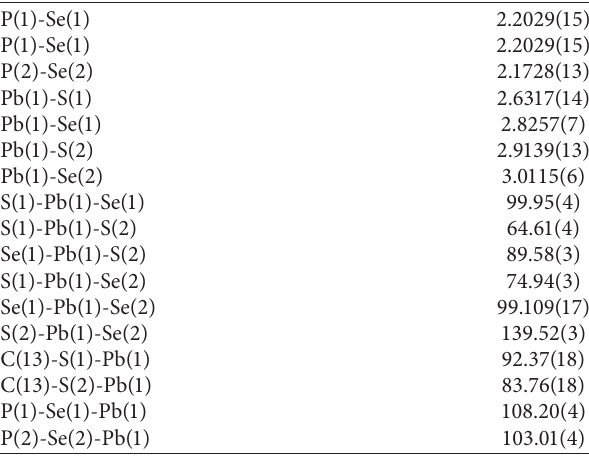
Table 2: Selected bond lengths (˚A) and angles ( °